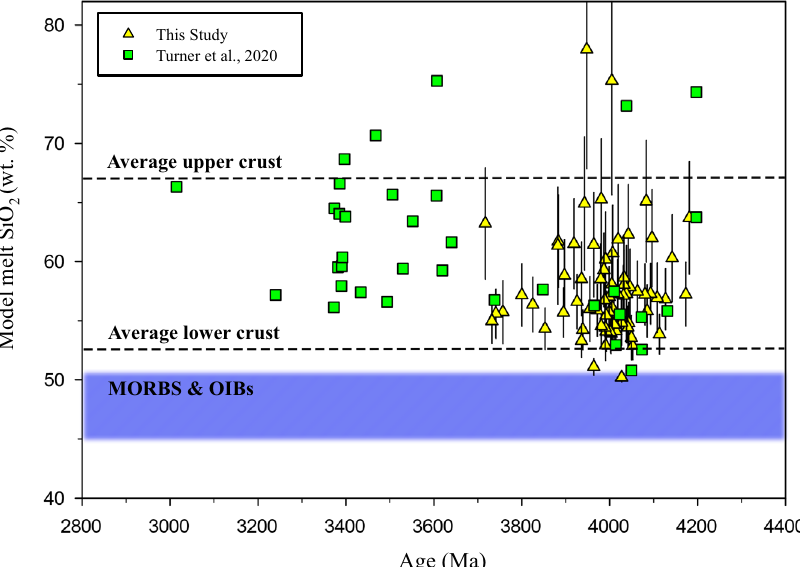
Fig. 1 | Calculated SiO 2 wt% of modeled Jack Hills zircons ’ parent melts ( n =77) against zircon 207 Pb- 206 Pb age. The melt SiO 2 contents are calculated using new trace element partition coef fi cients reported here (58±9wt% (2s.d.)) and are compared to those reported in ref. 6 (62±17wt% (2s.d.)), using the same D values. 18 of 95JHZ measurements were rejected (see Methods for rejection criteria); also shown are results from ref. 6 ( n =35). Field legend: horizontal dashed lines: